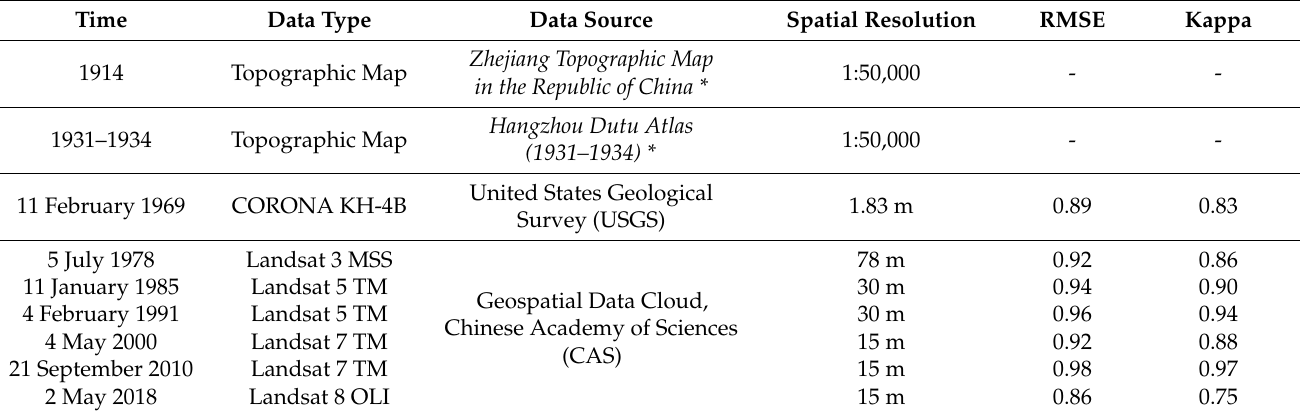
Table 1. Detailed parameters of data sources and classification accuracy of remote sensing